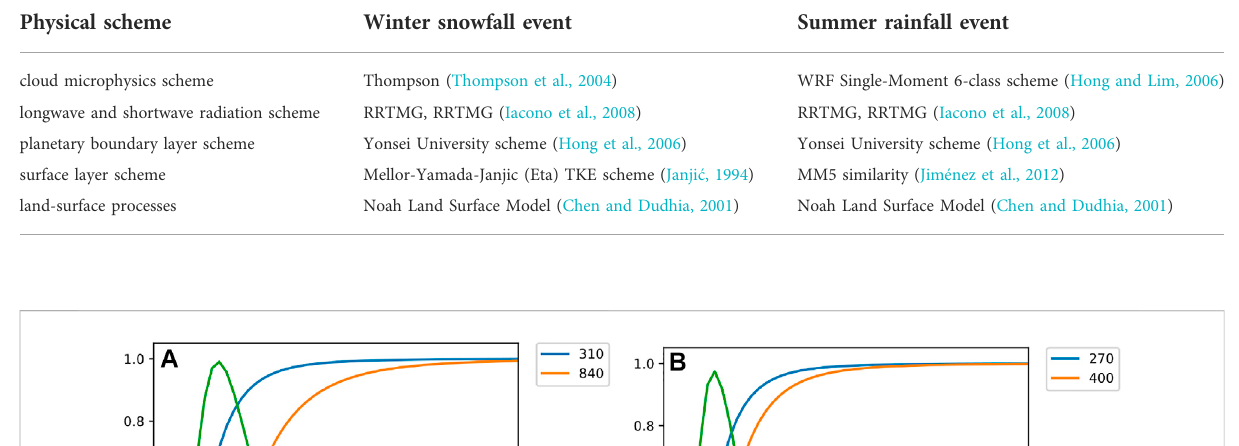
TABLE 1 Model scheme settings.